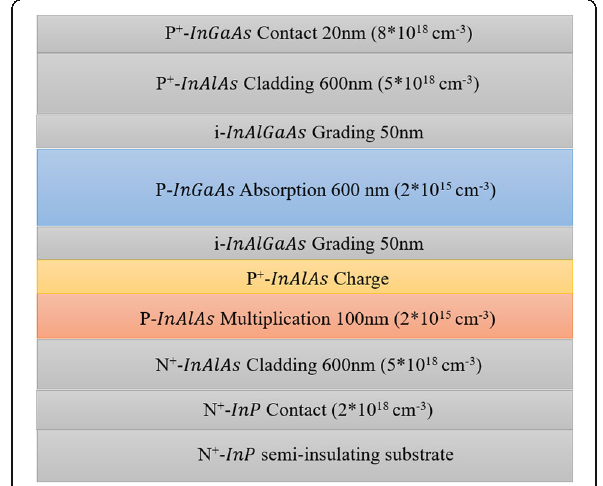
Fig. 1 Schematic cross-section of the front-illuminated SAGCM APDs. Presents the schematic cross-section of the top-illuminated SAGCM InGaAs/InAlAs APD. It includes structure, materials, doping, and thickness. From bottom to top, the layers are sequentially named as substrate, contact layer, cladding layer, multiplication layer, charge layer, grading layer, absorption layer, grading layer, cladding layer, and contact